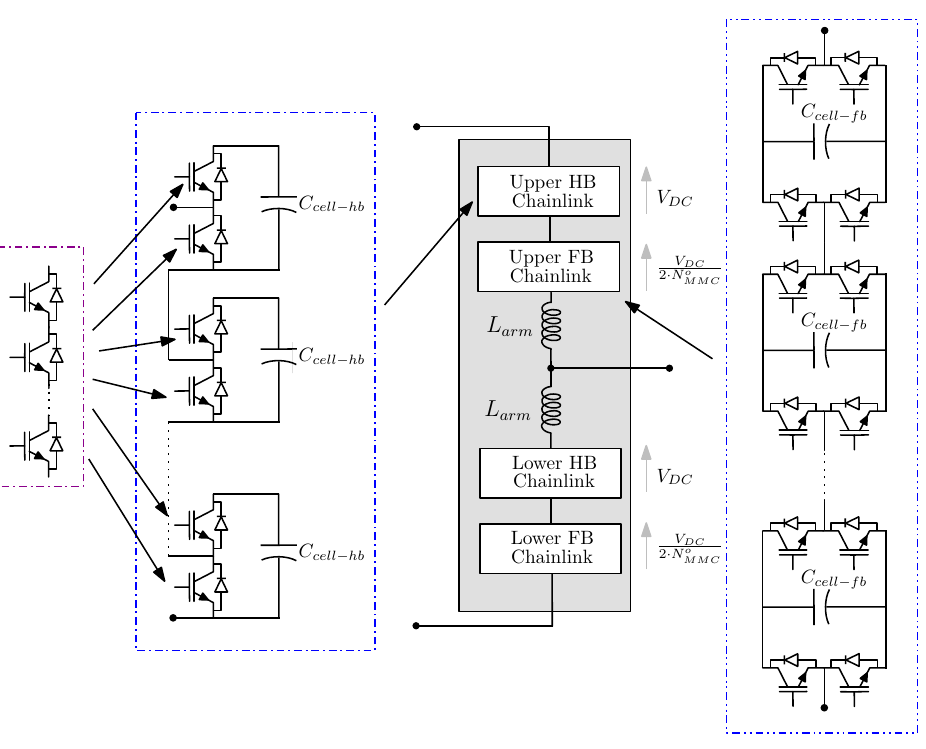
Figure 1. Phase representation of EMMC